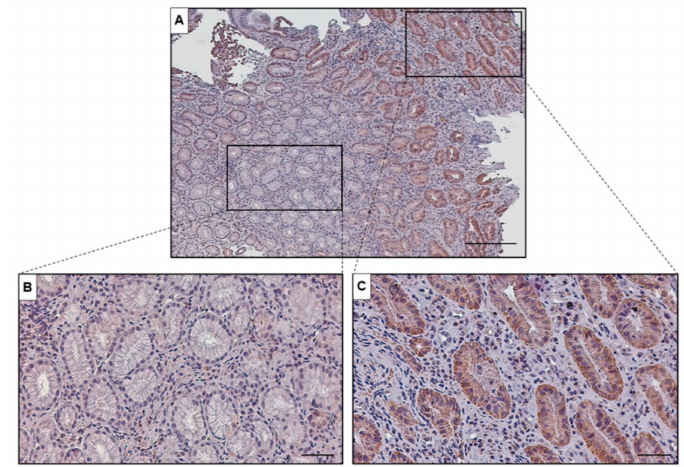
Figure 4. ( A ) Representative image of immunohistochemical detection of Hsp60 in gastric mucosa with areas of severe gastritis and areas with glandular dysplasia (magnification 50 × , scale bar 200 µ m). ( B ) Higher magnification of severe gastritis (magnification 200 × , scale bar 50 µ m). ( C ) Higher magnification of gastric dysplasia (magnification 200 × , scale bar 50 µ